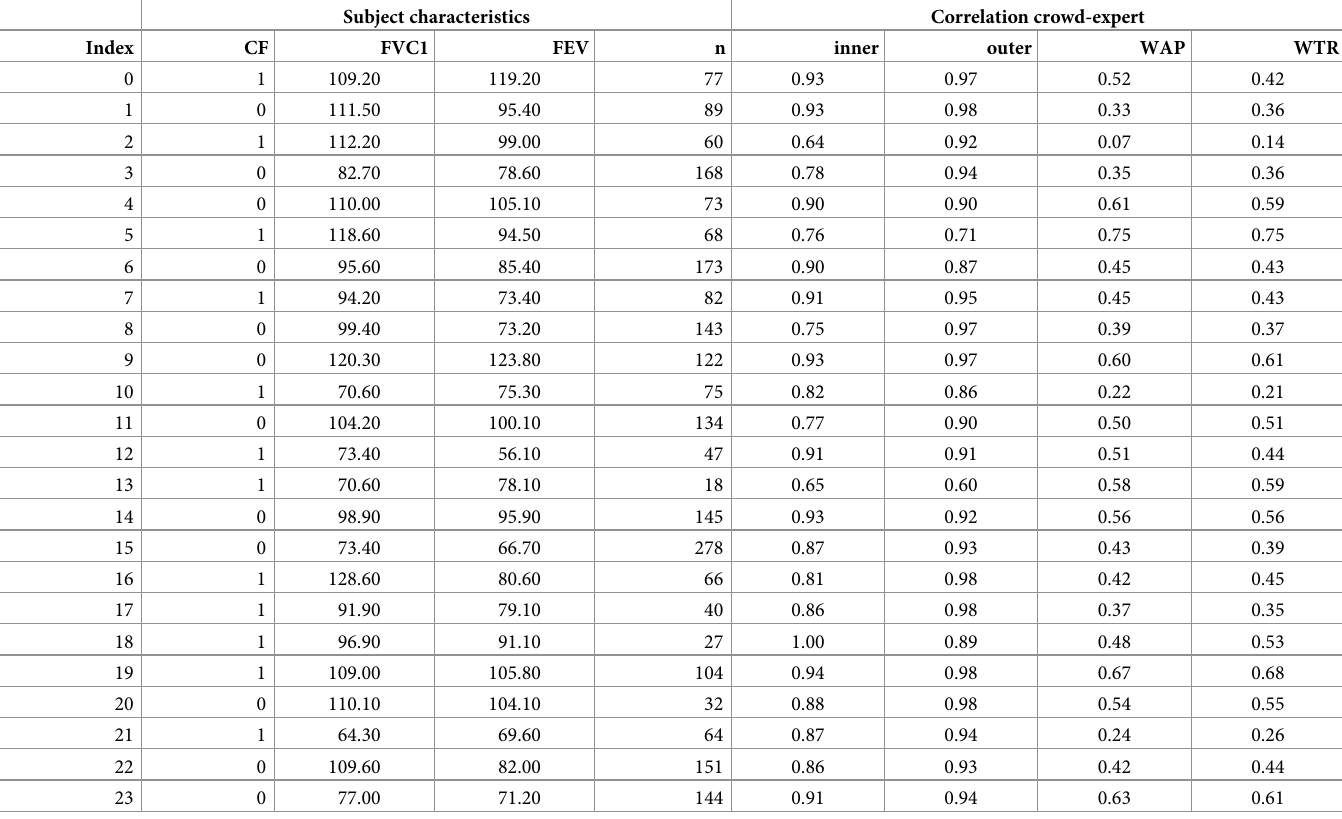
Table 3. Characteristics of the subject: ID (not used in modeling), whether a subject has CF (1 = yes), FVC1, FEV (as percentage of predicted value), number of air- ways (n), and correlations between the crowd (median combining) and the expert. Horizontal lines inserted for